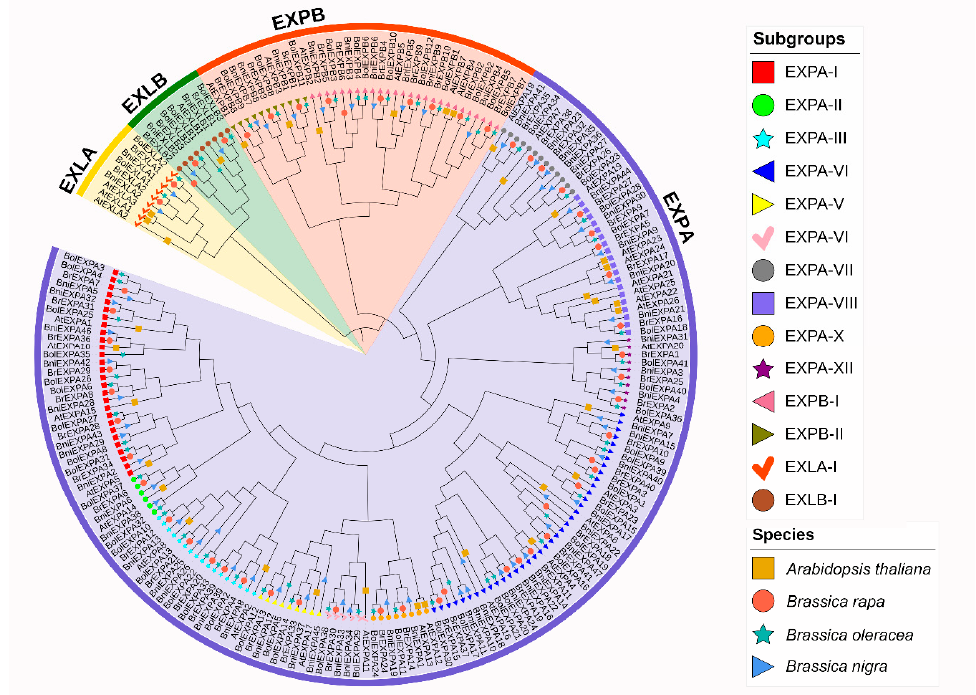
Figure 2. Phylogenetic relationship of A. thaliana , B. rapa , B. oleracea , and B. nigra expansin genes. The phylogenetic tree was constructed based on the complete protein sequence alignment of expansins in the four species by the maximum likelihood algorithm with bootstrapping analysis (1000 replicates) and the ‘WAG + G’ model. The four subfamilies are marked by colorful background.